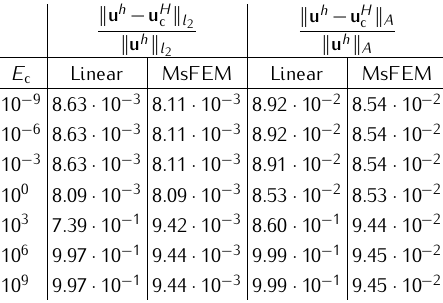
1 /h× 1 /h×H/h , h = 1 / 120 , H = 12